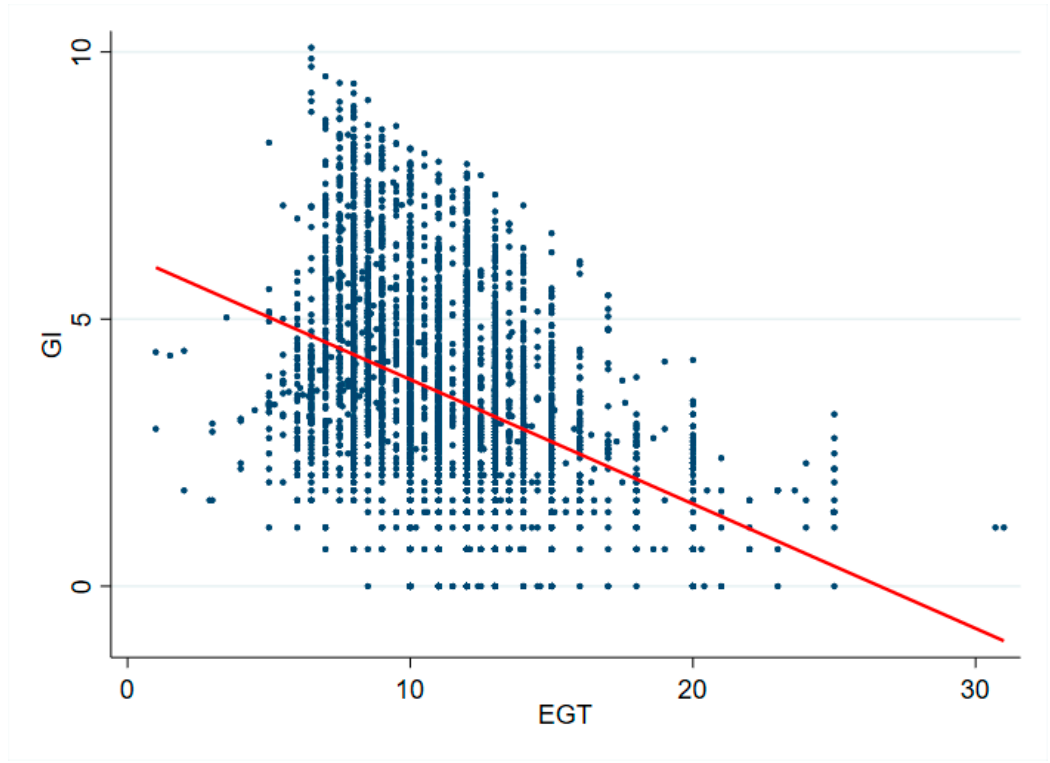
Figure 4. Scatter-plot of EGT and GI .